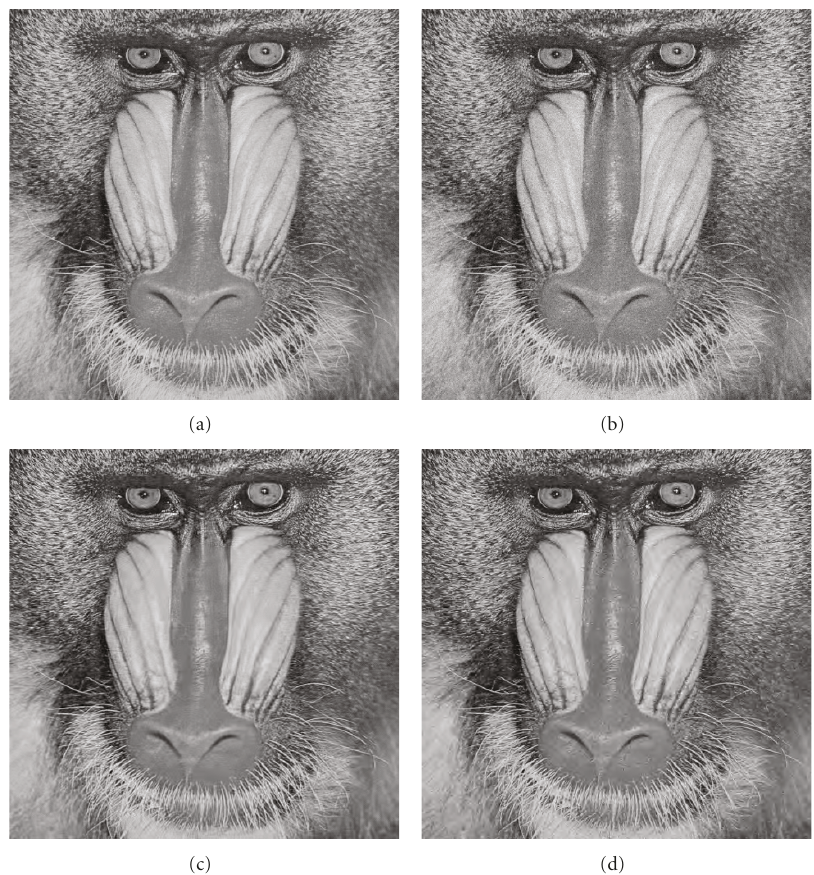
Figure 11: The image Baboon: (a) noise-free image, (b) noisy, σ 2 = 50, (c) compressed by ADCTC, b = 3 . 5, (d) compressed by SPIHT, bpp =